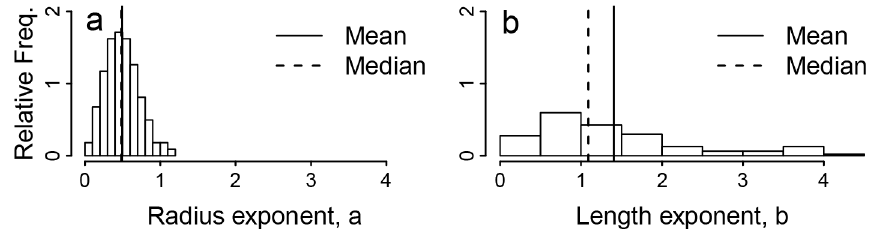
Fig 1. Conservation-Based Exponent Distribution. Plots of (a) the frequency distribution of the vascular scaling exponent a for vessel radius from solutions to Eq (1a) using empirical measurements of vessel radii extracted from magnetic resonance angiography using our software, and (b) the analogous frequency distribution of vascular scaling exponent b for vessel segment